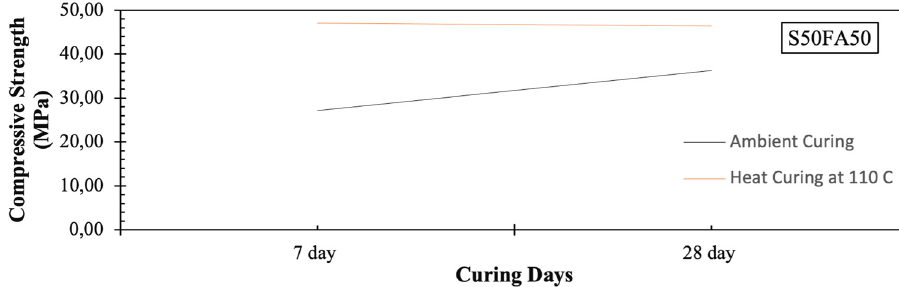
Figure 6: Compressive strength of ( 50GGBFS - 50FA ) specimens.